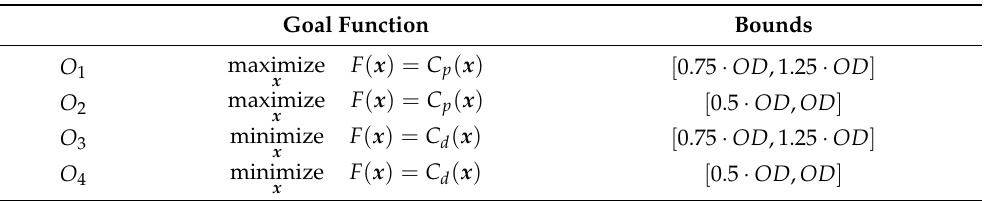
Table 5. Summary of considered optimization problems with respect to different goal functions and variable bounds. OD indicates original design, i.e., initial profile height.